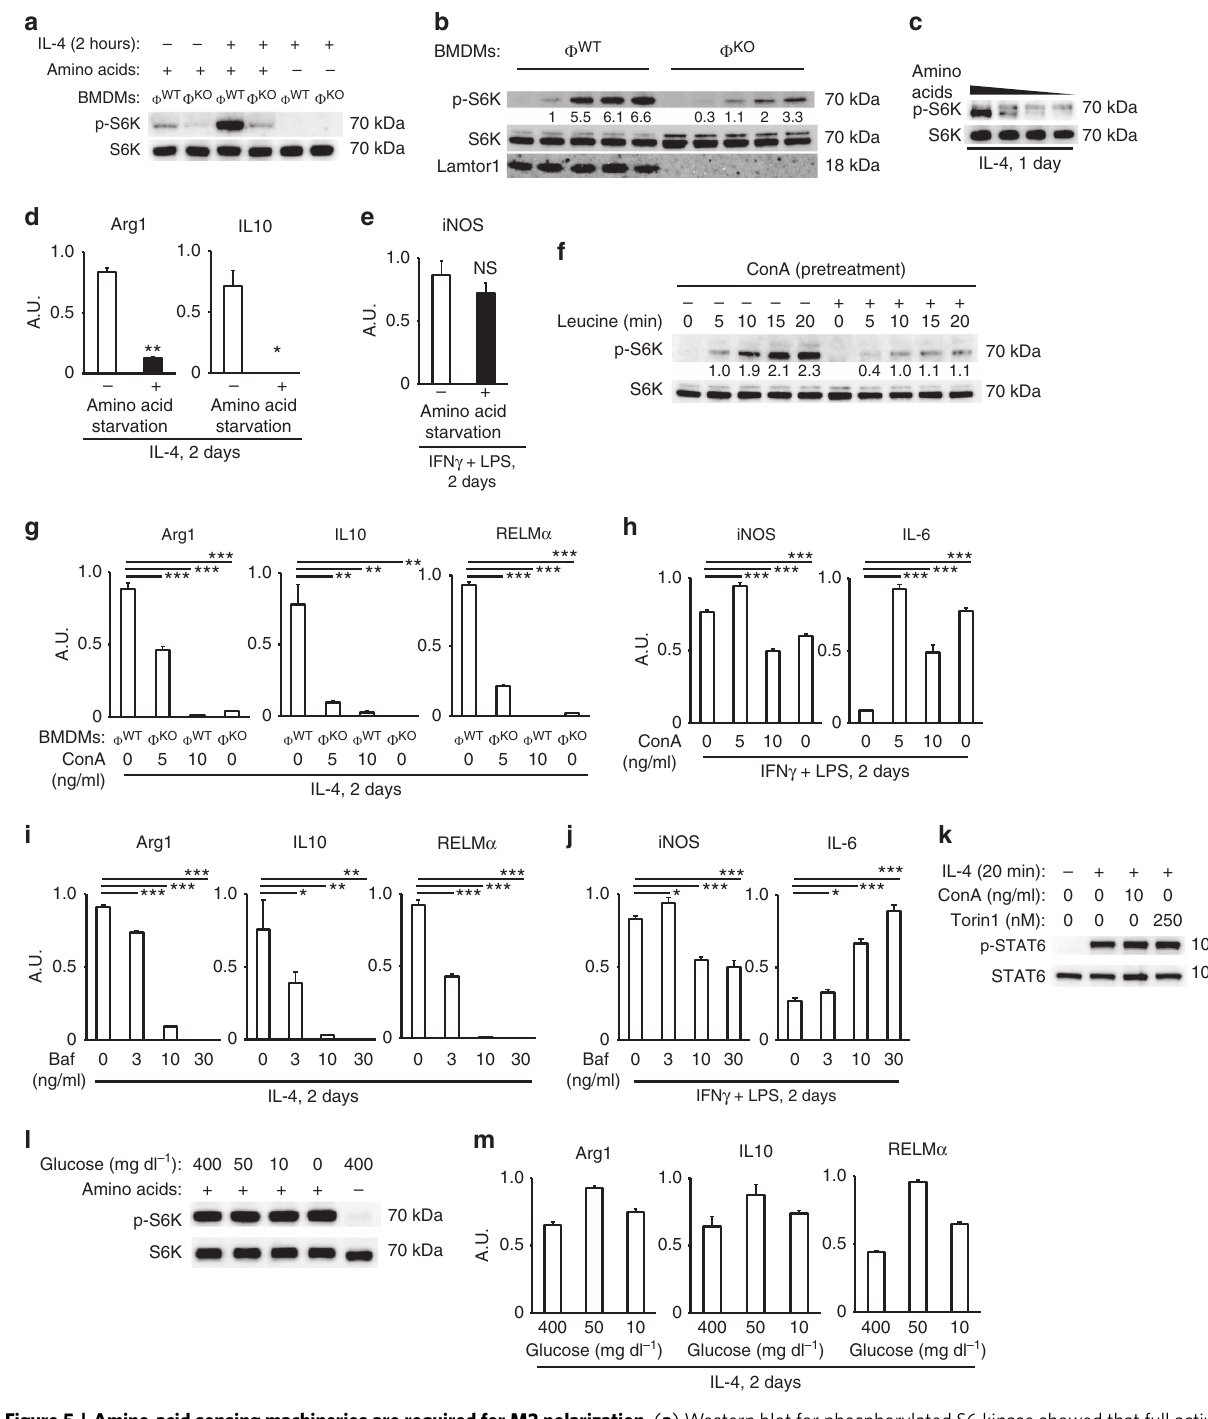
Figure 5 | Amino-acid sensing machineries are required for M2 polarization. ( a ) Western blot for phosphorylated S6 kinase showed that full activation of mTORC1 by IL-4 requires both Lamtor1 and amino acids. ( b ) Western blots for leucine (cid:2) elicited mTORC1 activation. After starved 1h for amino acids, BMDMs were stimulated with leucine (2mgml (cid:2) 1 ). ( c ) Western blots for phospho-S6 kinase in wild-type BMDMs stimulated with IL-4 in amino-acid starvation media. ( d , e ) Macrophage polarization in amino acid starvation media. Real-time PCR for M2 ( d ) and M1 ( e ) signature genes in amino acid (cid:2) starved wild-type BMDMs are shown. ( f – j ) Involvement of v-ATPase in amino-acid sensing and M2 polarization. ( f ) Western blots for leucine- elicited mTORC1 activation. After starved 1h for amino acids, BMDMs were stimulated with leucine (2mg/ml). Concanamycin A (ConA) was added 10min before leucine, and washed out just before the addition of leucine to media. ( g – j ) Real-time PCR for M2 ( g , i ) and M1 ( h , j ) signature genes in wild-type BMDMs polarized with each stimulant and concomitant ConA or Bafilomycin A1 (Baf). See Supplementary Fig. 8c for exclusion of unintended suppressive effect of the vehicle. ( k ) Western blots for STAT6 phosphorylation in wild-type BMDMs treated with IL-4 and concomitantly used inhibitors for v-ATPase or mTOR. ( l ) Western blots for mTORC1 activity. Amino acid (cid:2) starvation (1h) abolished phosphorylation of S6 kinase, but glucose starvation (1h) did not. ( m ) Real-time PCR for M2 marker genes expressed in wild-type BMDMs cultured in low-glucose media. F WT and F KO are defined as in Fig. 1. The representative results of three independent experiments are shown for each panel. * P o 0.05, ** P o 0.01, *** P o 0.001. Error bars show s.d. NATURE COMMUNICATIONS|7:13130|DOI: